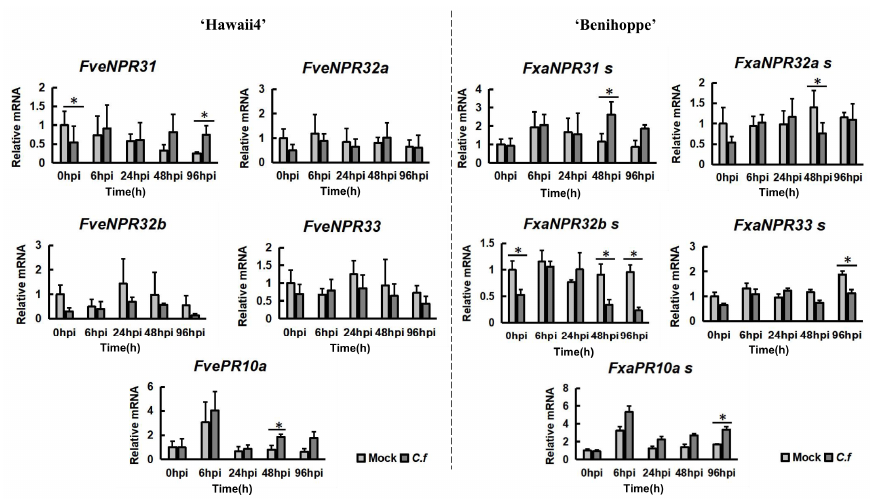
Figure 7. A quantitative RT-PCR analysis of strawberry NPR3 -like genes upon C. fructicola invasion